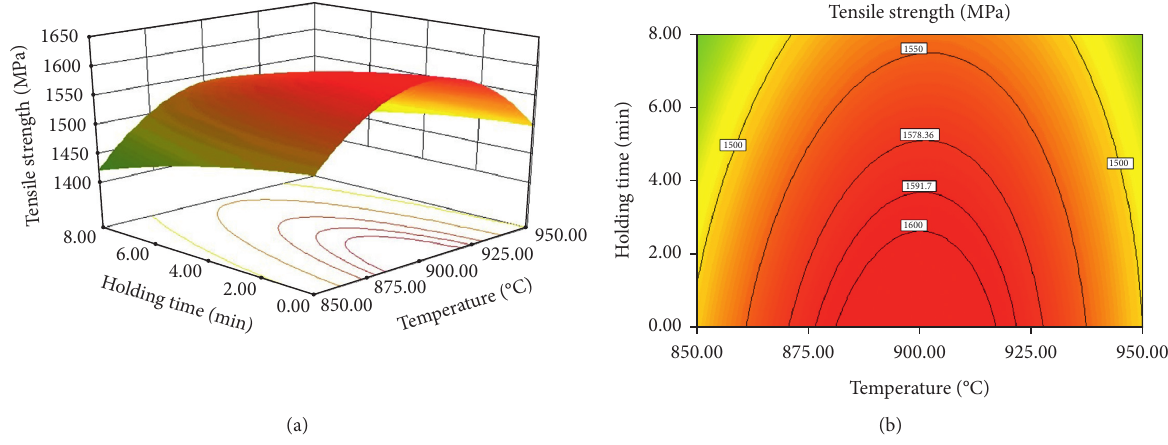
Figure 9: (a) 3D response surface for tensile strength and (b) 2D contour for tensile strength.